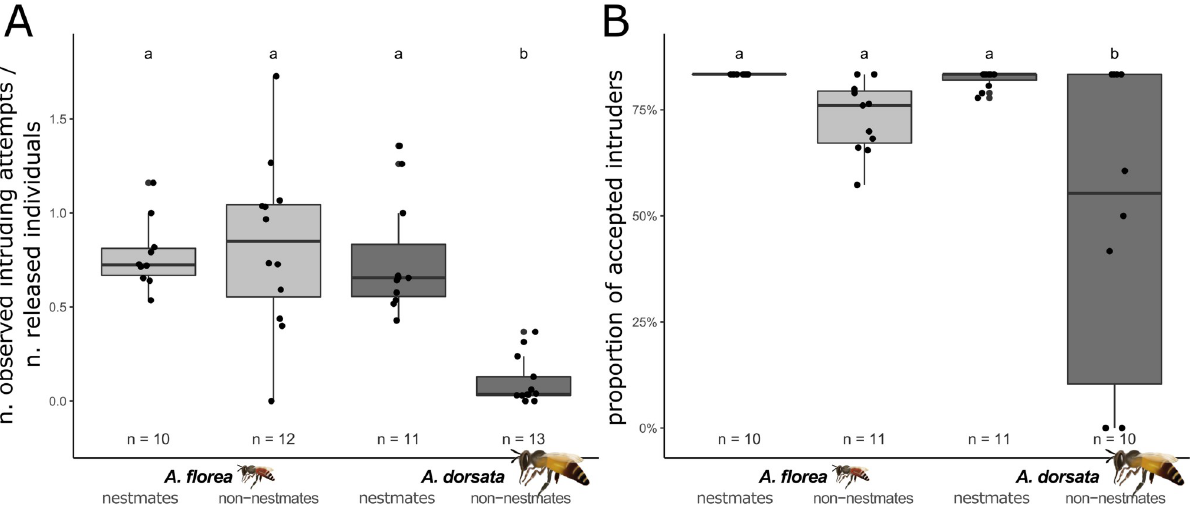
Fig 6. Intruding attempts and acceptance. (A) Differences in the proportion of intruding attempts (measured as the proportion of observed intruding individuals to released individuals) between nestmates and non-nestmates in A . florea and A . dorsata are presented. (B) Differences in the proportion of accepted individuals between released nestmates and non-nestmates and between species ( A . florea and A . dorsata ) are shown. Letters indicate differences in the proportion of accepted individuals achieved via post-hoc test (Tukey). The number of observed cohorts is indicated with